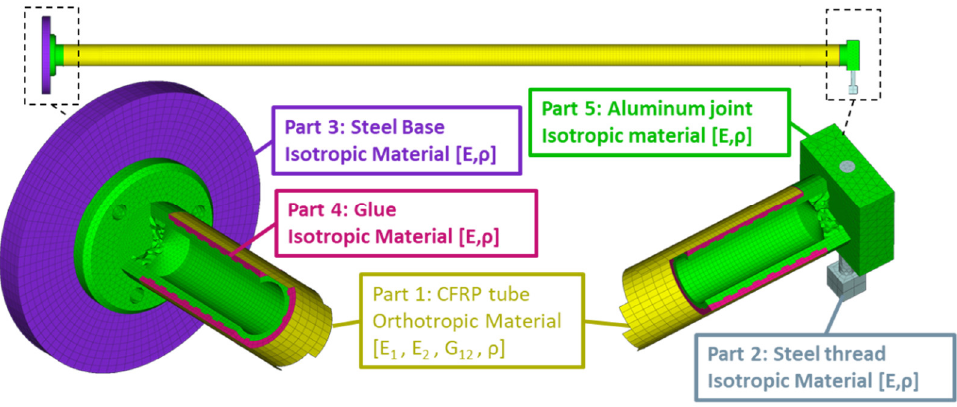
Figure 17. FE Model of the cantilever CFRP beam.